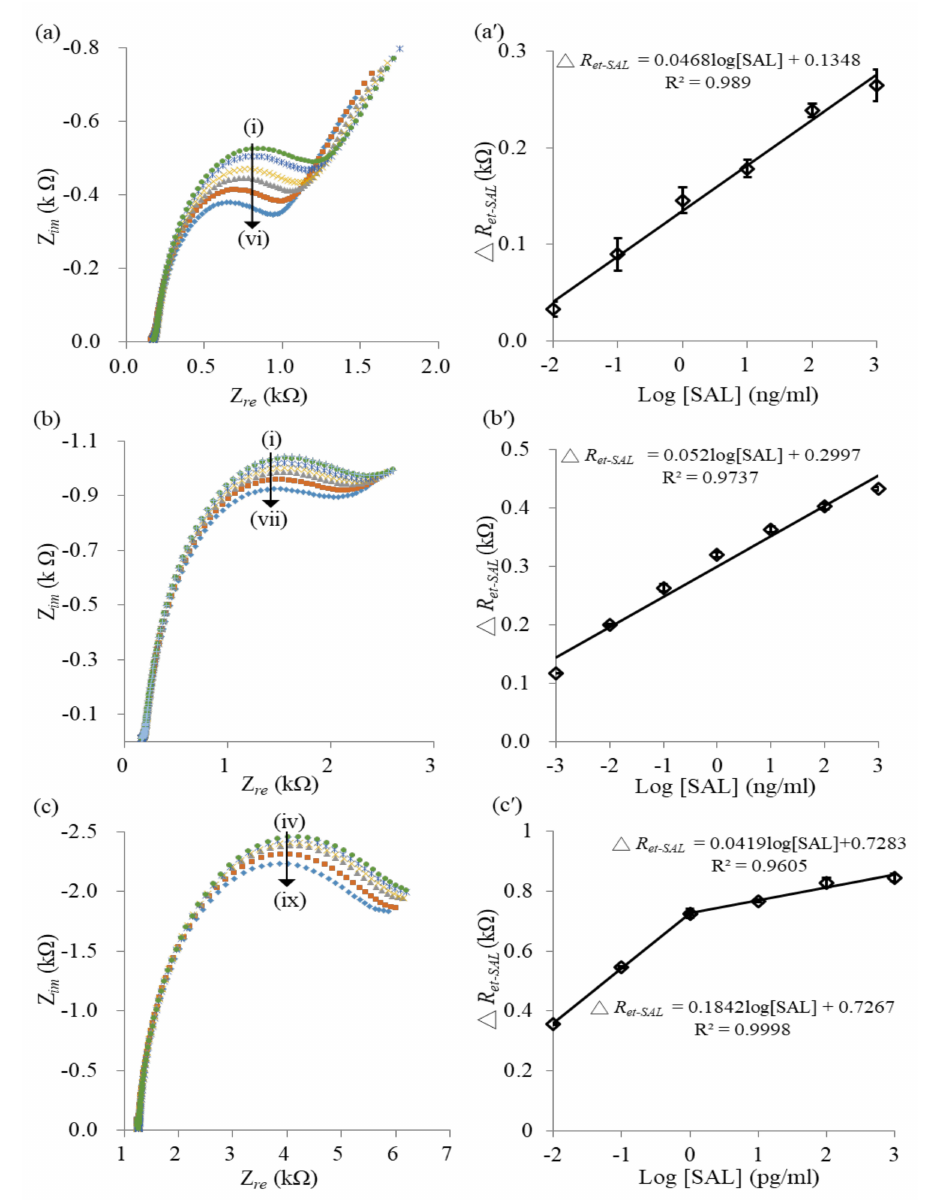
Figure 4. Impedance spectra of the anti-SAL / MPA / AuNS / SPCE- ( a ), the anti-SAL / PA(100):BSA(0) / MPA / AuNS / SPCE- ( b ) and the anti-SAL / PA(100):BSA(100) / MPA / AuNS / SPCE-based ( c ) immunosensors interacting with concentration-different SAL samples. Curves (i) − (ix) respectively represent 1 µ g / mL, 100 ng / mL, 10 ng / mL, 1 ng / mL, 100 pg / mL, 10 pg / mL, 1 pg / mL, 100 fg / mL and 10 fg / mL SAL. ( a (cid:48) − c (cid:48) ) are the calibration curves corresponding to ( a − c ) ( n =